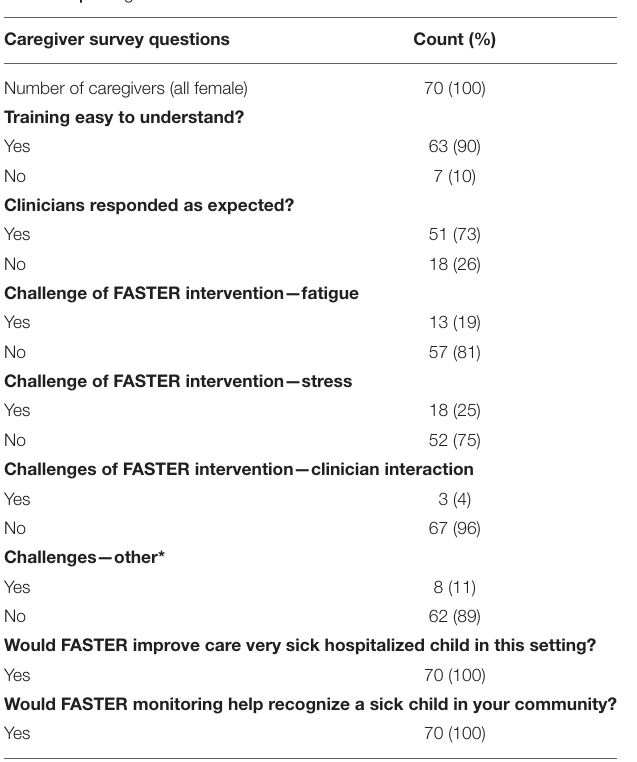
TABLE 3 | Caregiver feedback of FASTER intervention.